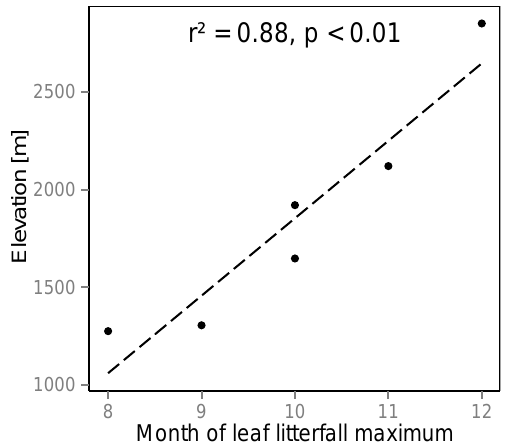
Figure 3. Linear regression between elevation and month of highest leaf litterfall in six ecosystems of Mt. Kilimanjaro.